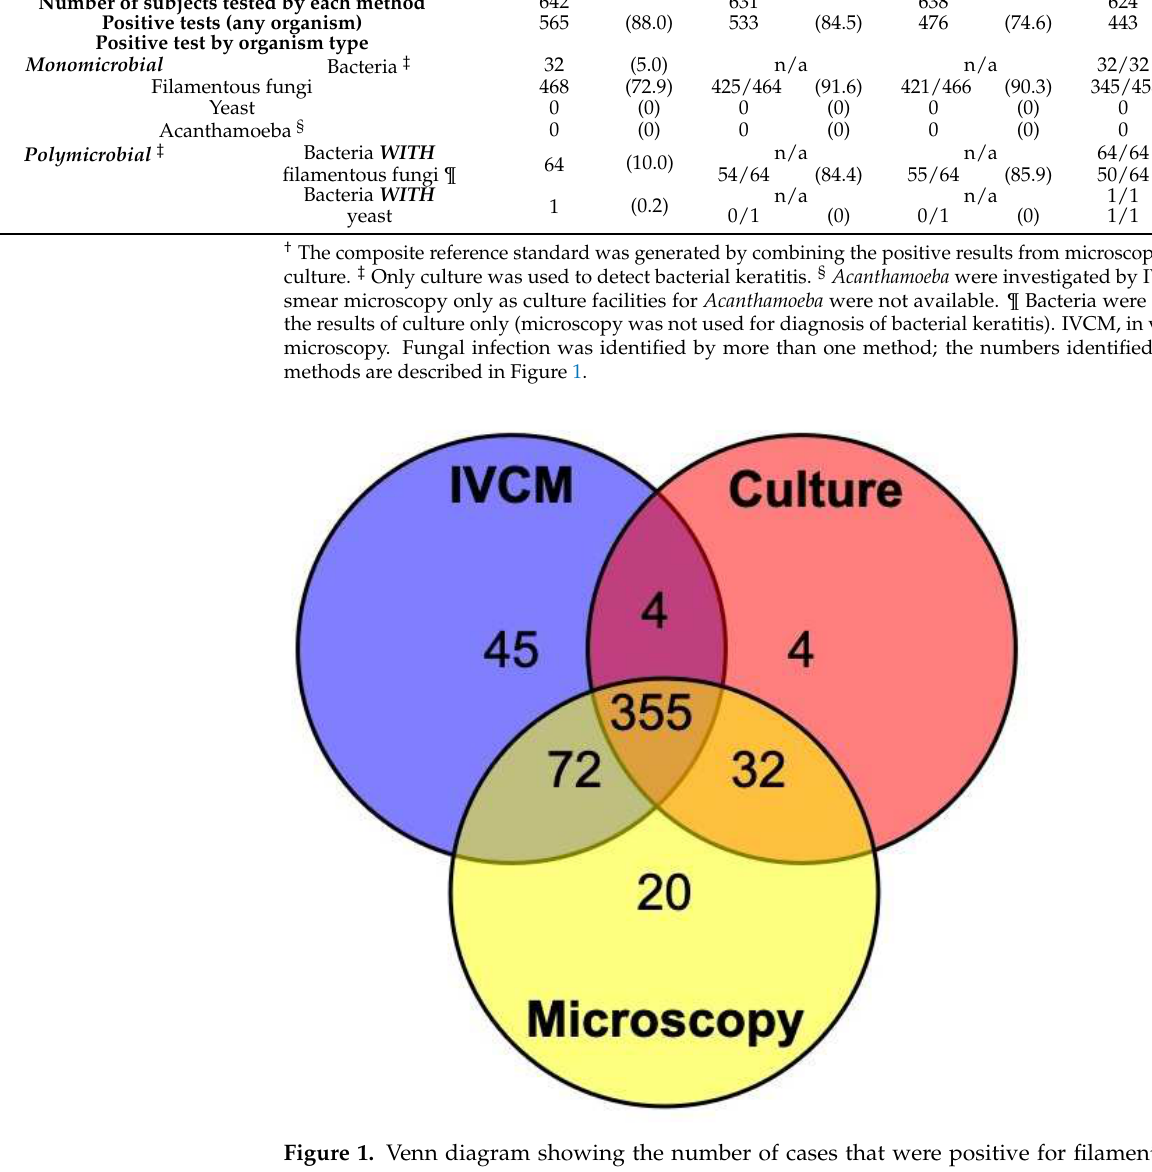
Figure 1. Venn diagram showing the number of cases that were positive for filamentous fungal keratitis ( n = 532, including mixed bacterial-fungal cases) using culture, smear microscopy, and in vivo confocal microscopy (IVCM). Cases that were positive for more than one test are given within the overlapping areas. Note that cases that were negative for all investigations are not included, and not all patients had all tests performed. Please refer to Tables 1 and 2 for this information.